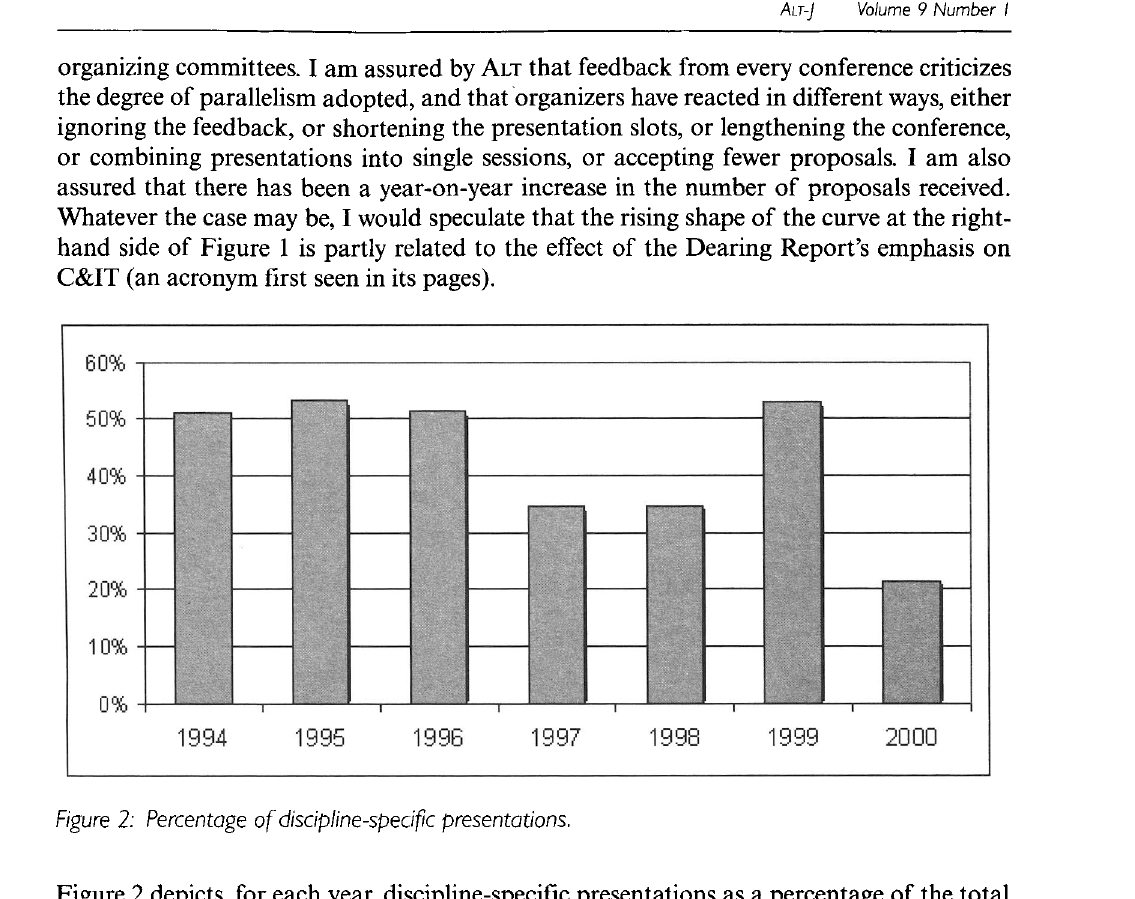
Figure 2: Percentage of discipline-specific